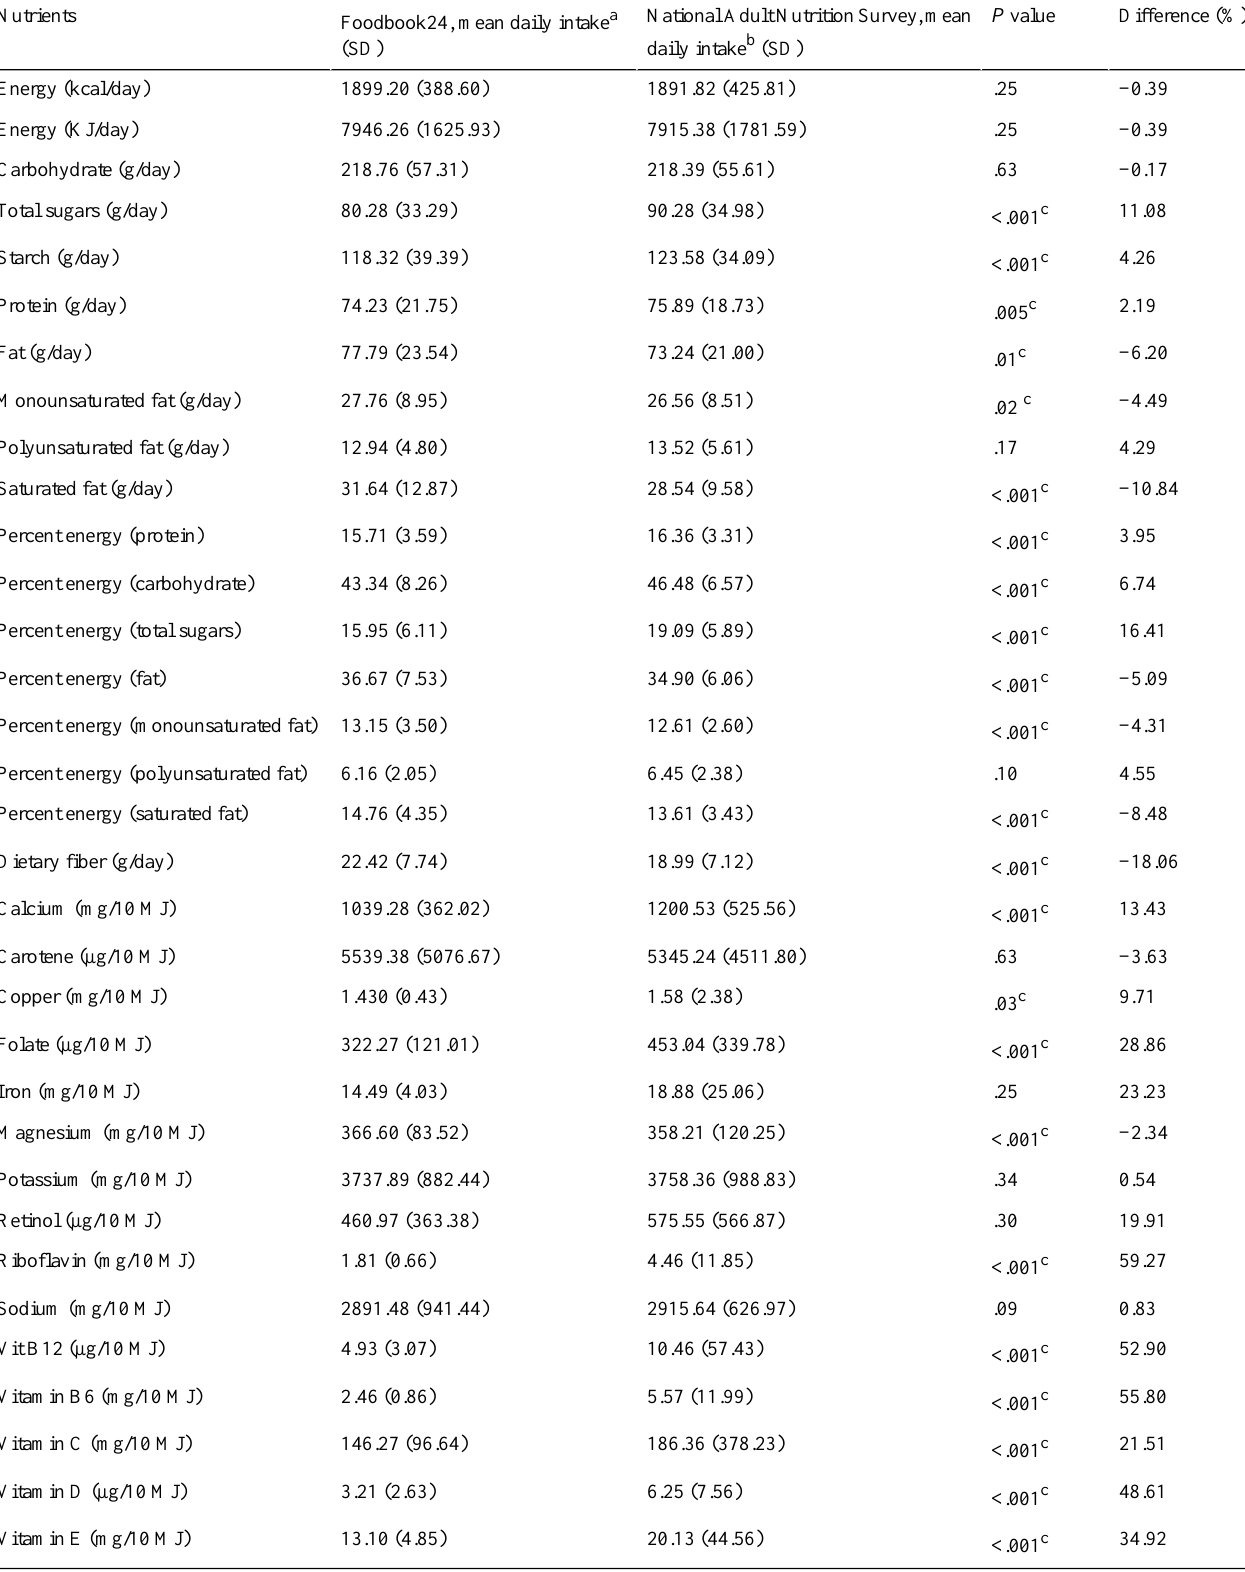
Table 3. Nutrient intakes of female adequate reporters from the Foodbook24 web-based study (2016) and the National Adult Nutrition Survey (2011).